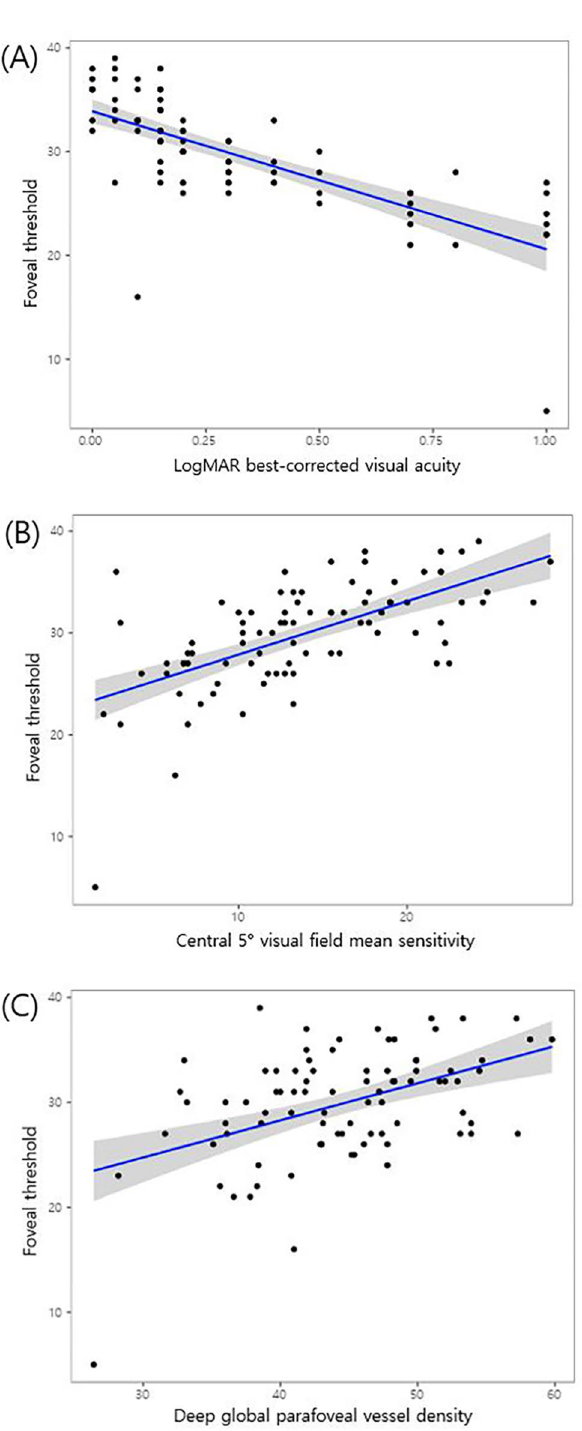
Figure 1. Scatterplot and best fit-line between foveal threshold and various covariates. ( A ) Foveal threshold by LogMAR best-corrected visual acuity (r 2 = 0.518, P < 0.001, linear regression analysis), ( B ) foveal threshold by central 5° visual field mean sensitivity (r 2 = 0.386, P < 0.001, linear regression analysis), and ( C ) foveal threshold by deep global parafoveal vessel density (r 2 = 0.212, P < 0.001, linear regression